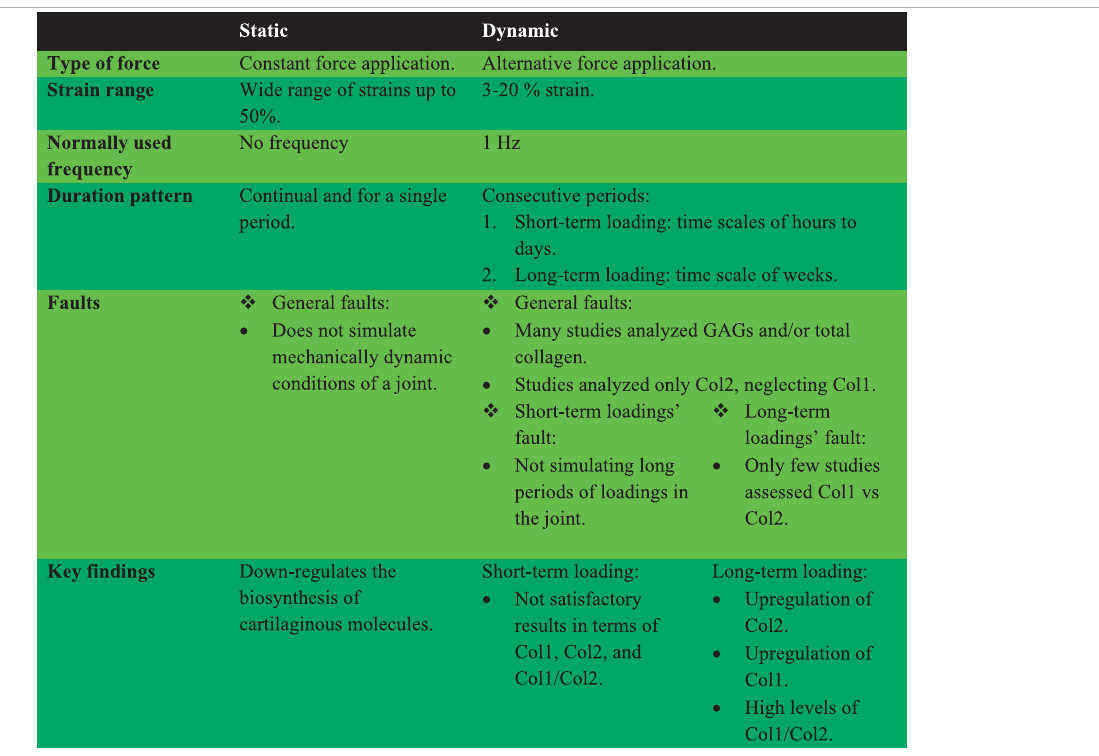
TABLE 2 | Summary of information for various in vitro compression